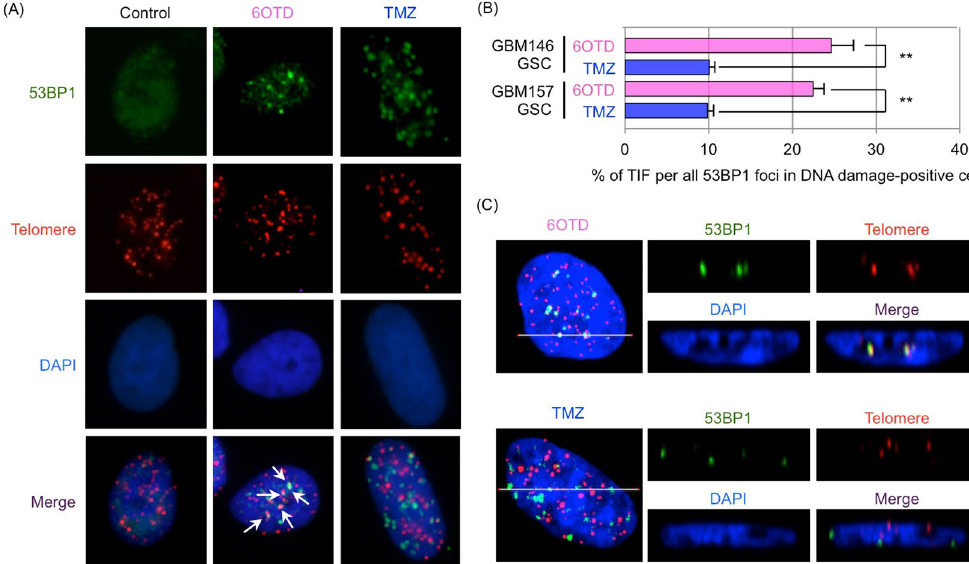
Figure 5. 6OTD preferentially attacks telomeric DNA in GSCs. ( A ) iFISH analysis for evaluating telomere dysfunction-induced foci (TIF) in GBM146 cells (GSCs) treated with DMSO, 6OTD (100 nM), or TMZ (10 μ M) for 3 days. Cells were labeled with anti-53BP1 antibody and PNA probe for G-rich telomeric DNA. White arrows indicate TIF. ( B ) Quantitative analyses of the percentage of TIF in all 53BP1 foci in DNA damage-positive cells. At least 100 cells were analyzed for each condition. Each bar represents the mean ± SD ( ** P < 0.01). ( C ) Z -stack image of 6OTD (upper) and TMZ (lower)-treated GSCs and consecutive xz images on white lines of those